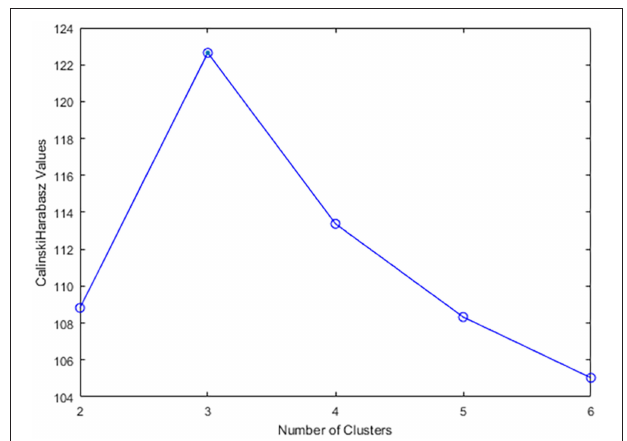
FIGURE 3 | Calinski-Harabasz score corresponding to different number of clusters.